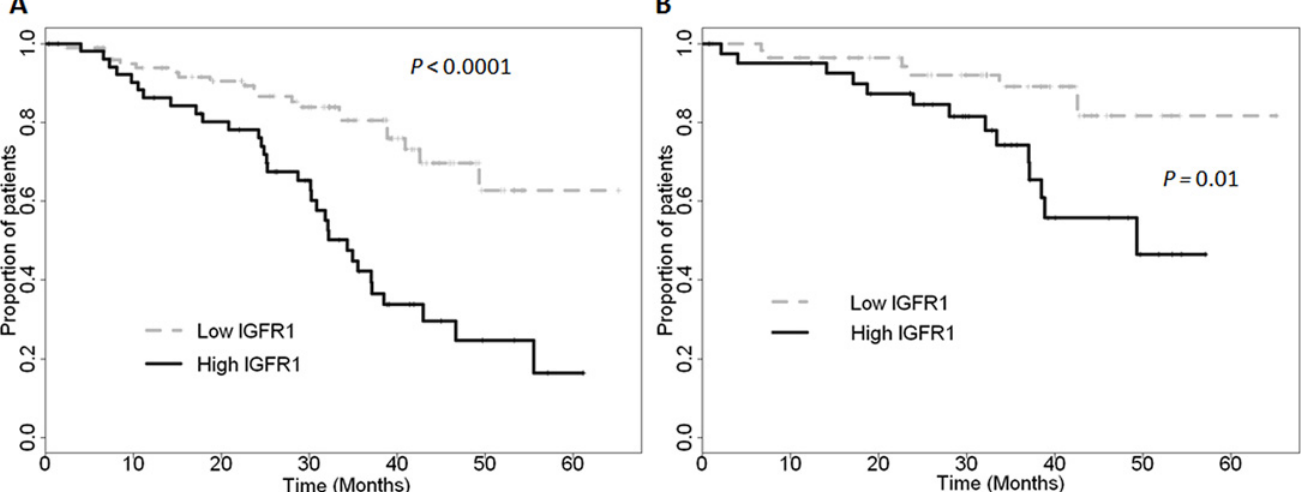
Fig 4. Kaplan-Meier estimated curves of time to first treatment according to IGF1R expression considering all CLL patients (A) and only IGHV -M patients (B).